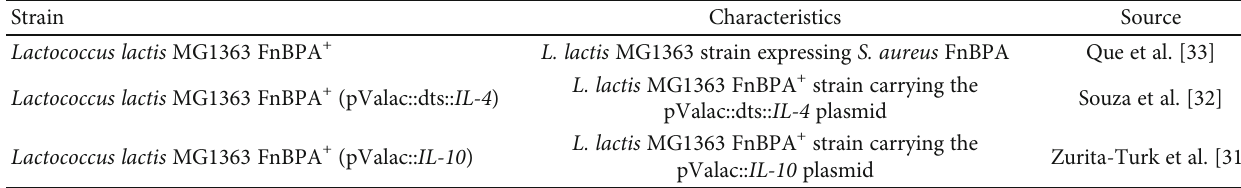
Table 1: Bacterial strains used in this